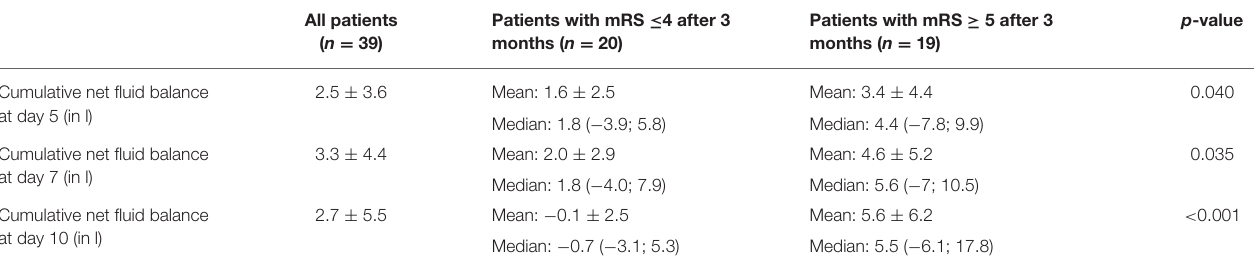
TABLE 3 | Cumulative net fluid balance.